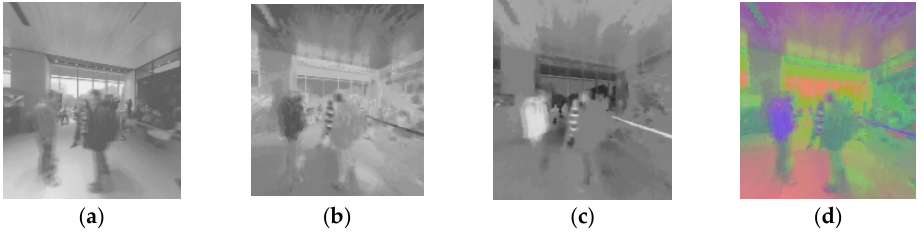
Figure 5. An example of binocular fusion map. ( a ) Y channel, ( b ) U channel, ( c ) V channel, ( d ) three-channel combination with the visualization of pseudo color.